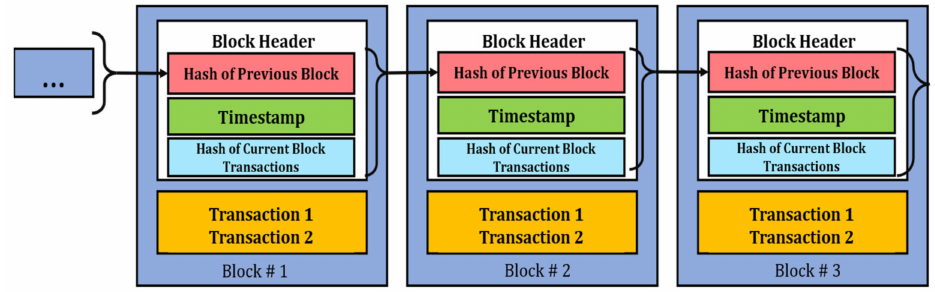
Figure 3. Structure of